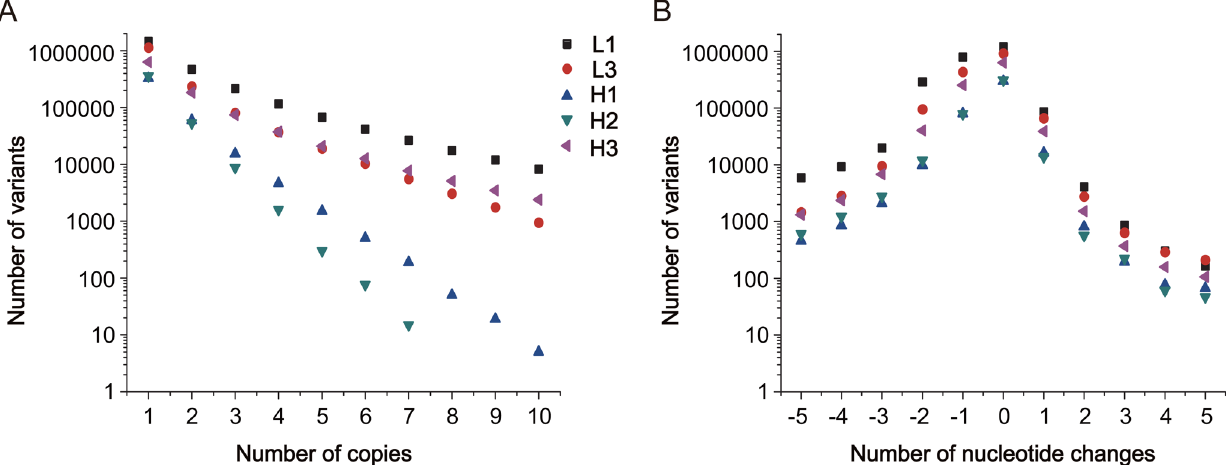
Fig 2. Characterization of library CDR sequences. Data analysis was performed for the five individual CDRs from 13.9 million qualified sequences in the unselected libraries. (A) Sequence abundance analysis. Each point represents the total number of variants with a specific copy number. Only variants with (cid:1) 10 copies are shown. (B) Length distribution analysis. Each point represents the total number of variants of a specific length. Only variants with (cid:1) 5 nucleotide deletions or insertions are